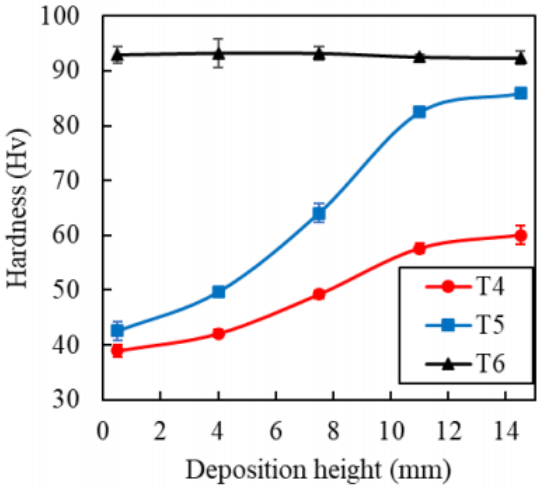
Figure 13. Hardness distribution along the deposition height of AA6063 [37].